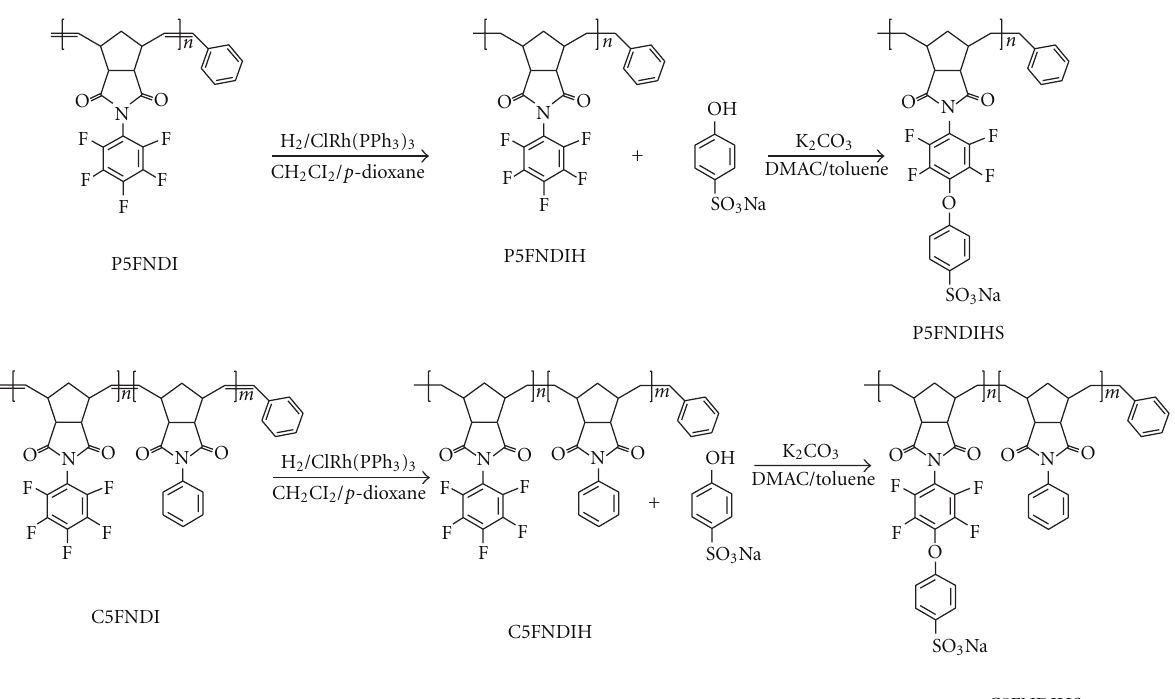
Scheme 2: Synthesis of sulfonated polymer and copolymer.